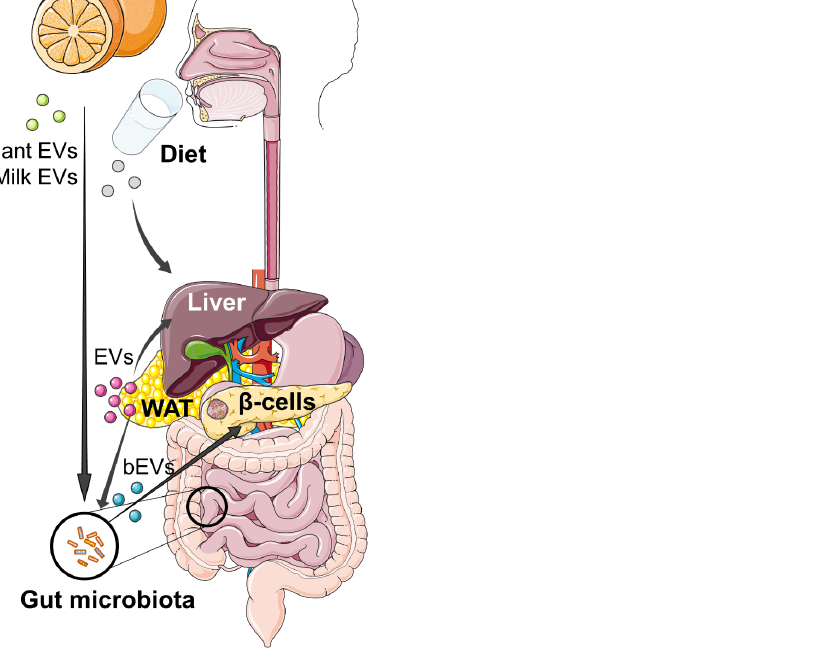
Figure 4. EVs found in edible vegetables or milk, or released by the gut microbiota and the different organs, participate in a multi ‐ directional, inter ‐ kingdom crosstalk that is required to coordinate metabolic processes and maintain homeostasis in the host. See text for details.